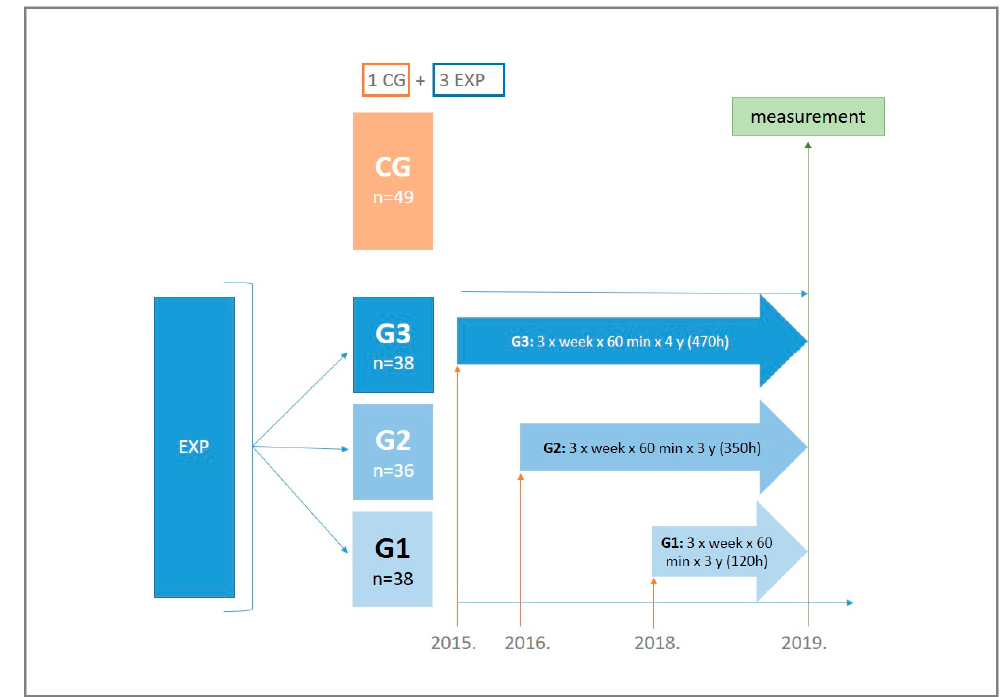
Figure 1. Study progress and inclusion of individual experimental groups in different time periods from 2015 to 2019. CG—control group, EG—experimental group, G1—120 h of exercise, G2—350 h of exercise, G3—470 h of exercise.